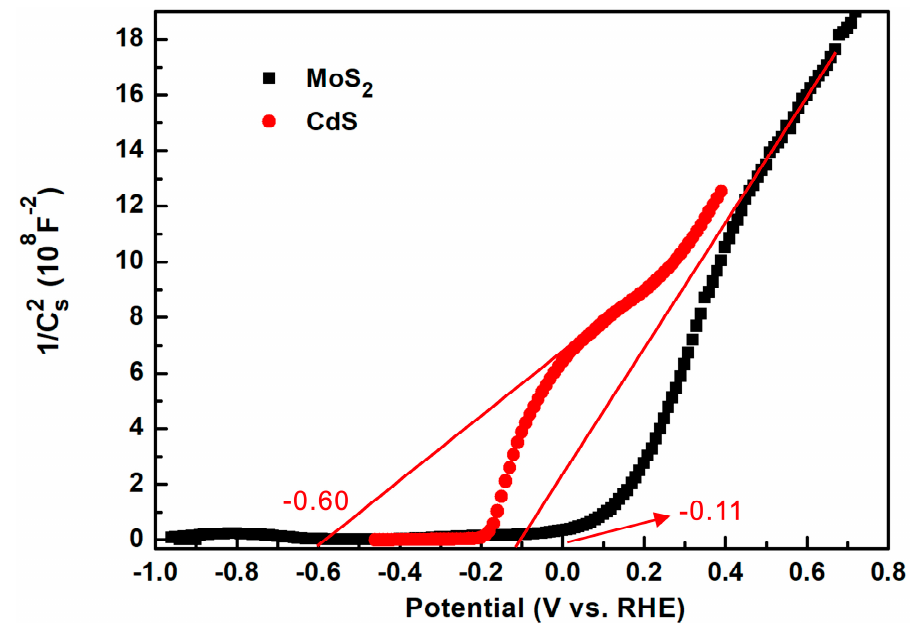
Figure 8. Mott–Schottky curves of pure MoS 2 and CdS. RHE—reversible hydrogen electrode.